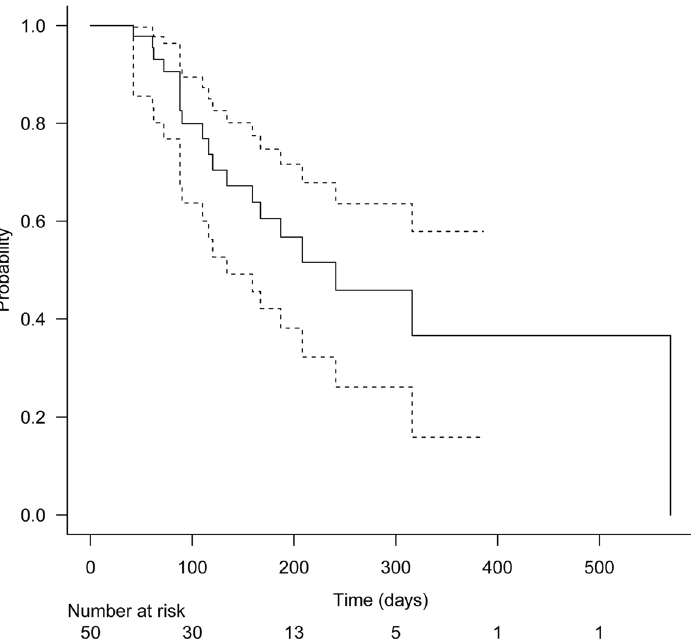
Figure 3. Kaplan–Meier analysis of the time to recurrent biliary obstruction. The median time to recurrent biliary obstruction was 241 days (95% confidence interval, 134-not applicable)